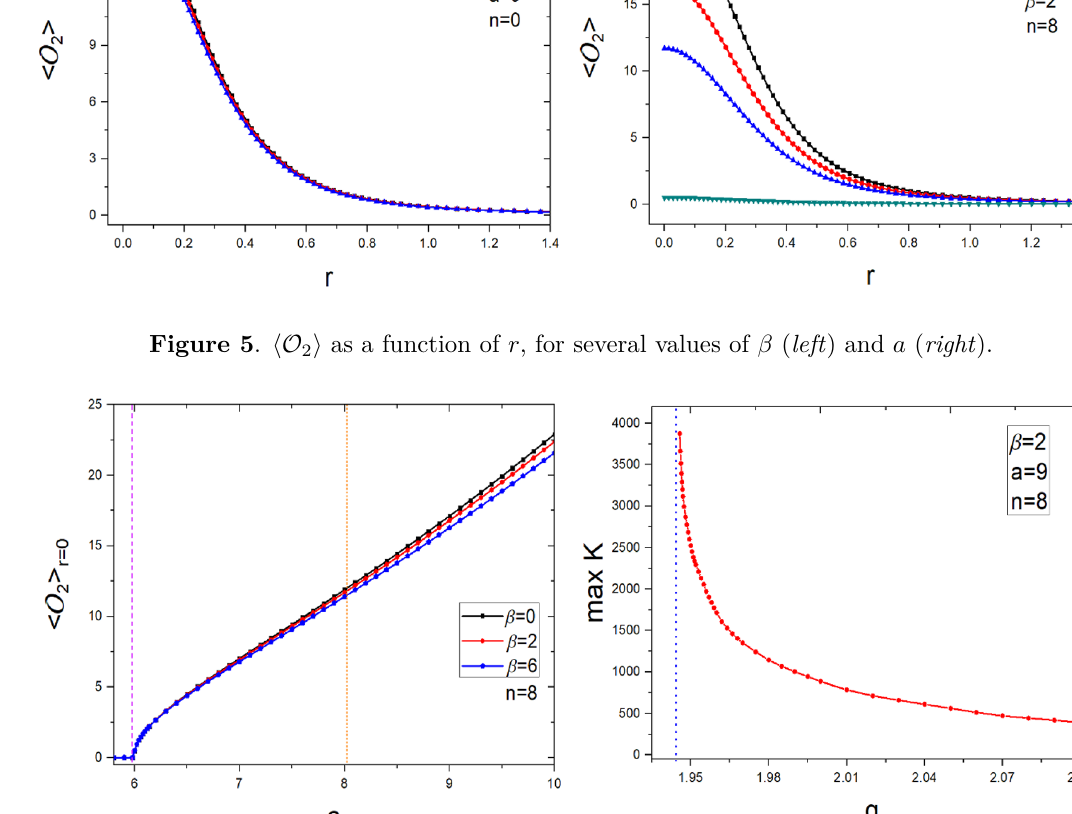
Figure 6 . Left : hO 2 i r =0 against a at fixed q = 2 . 1 , for several values of β > 0 . The purple dashed vertical gridline corresponds to a = 5 . 98 while the orange dotted one to a max = 8 . 06 . Right : approach to the singular solution for fixed β = 2 and a = 9 . The vertical gridline marks q min = 1 . 945